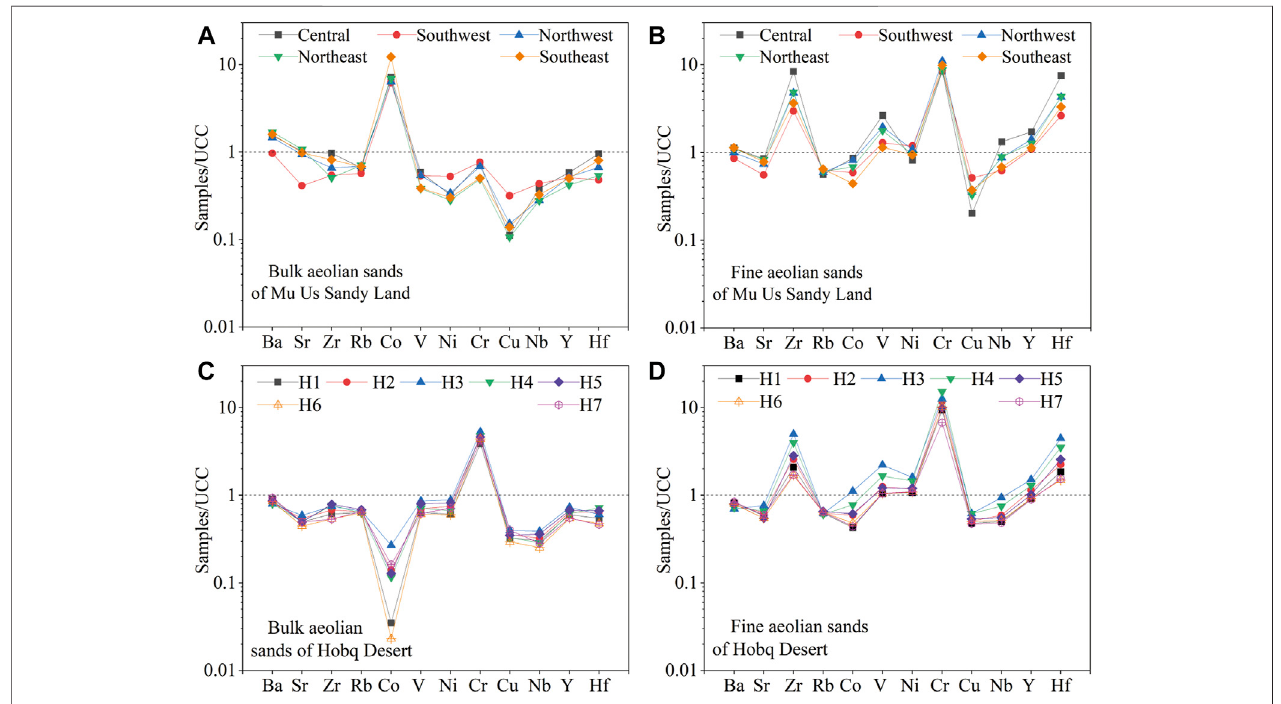
FIGURE 5 | UCC-normalized distribution patterns of trace elements. (A,B) are for bulk and fi ne fraction sands in the Mu Us Sandy Land, respectively. (C,D) are for bulk and fi ne fraction sands in the Hobq Desert, respectively. UCC values from Taylor and McLennan (1985).